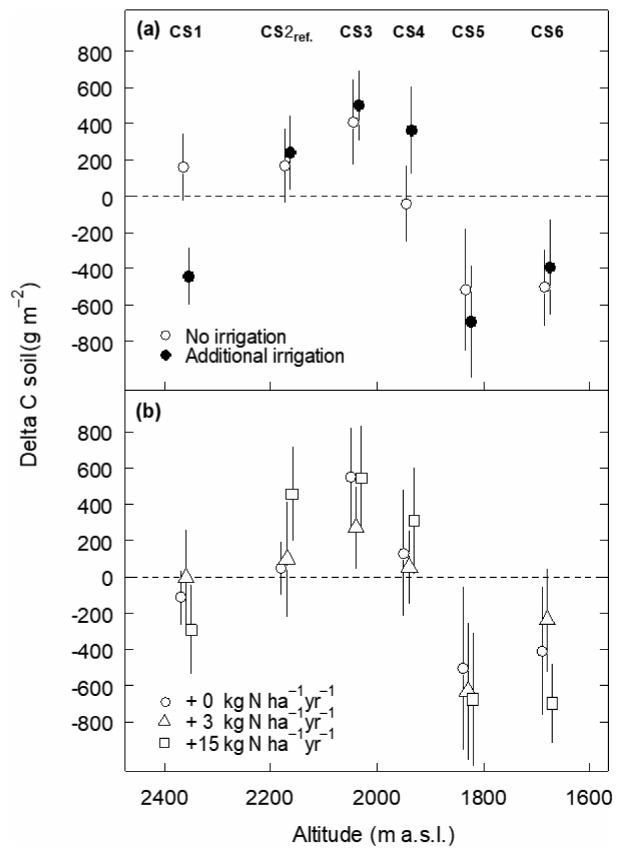
Figure A1. Soil carbon stock change (Delta C) of subalpine grass- land between 2012 and 2017 as a function of the altitude of cli- mate scenario sites (CSs) and (a) the irrigation treatment and (b) the N deposition treatment (0, 3, 15kgNha − 1 yr − 1 , in addition to 4– 5kgN background deposition). Data denote means ± 1SE, shifted horizontally to improve their visibility.